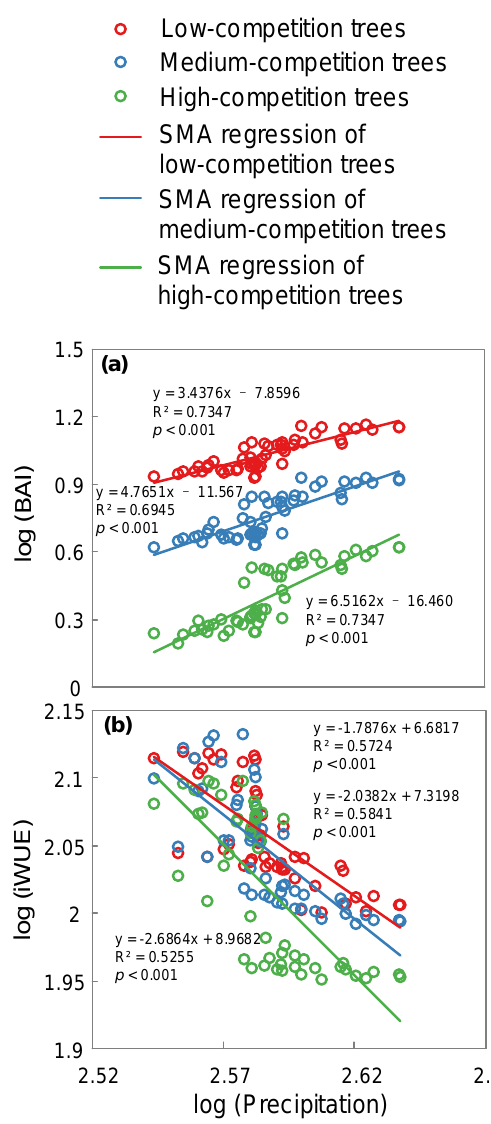
10 of 18 Figure 4. Average trunk iWUE (SE) of different competition groups ( n = 3, 3, and 3) for ( a ) all years